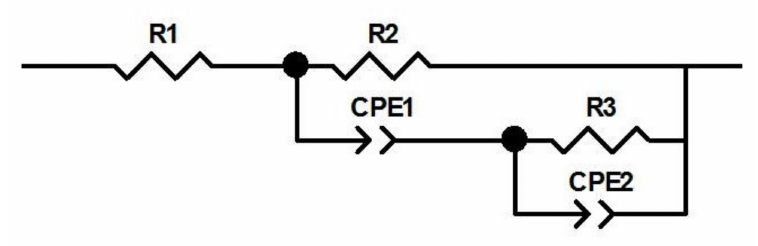
Figure 8. The equivalent electric circuit, used for fitting the data.